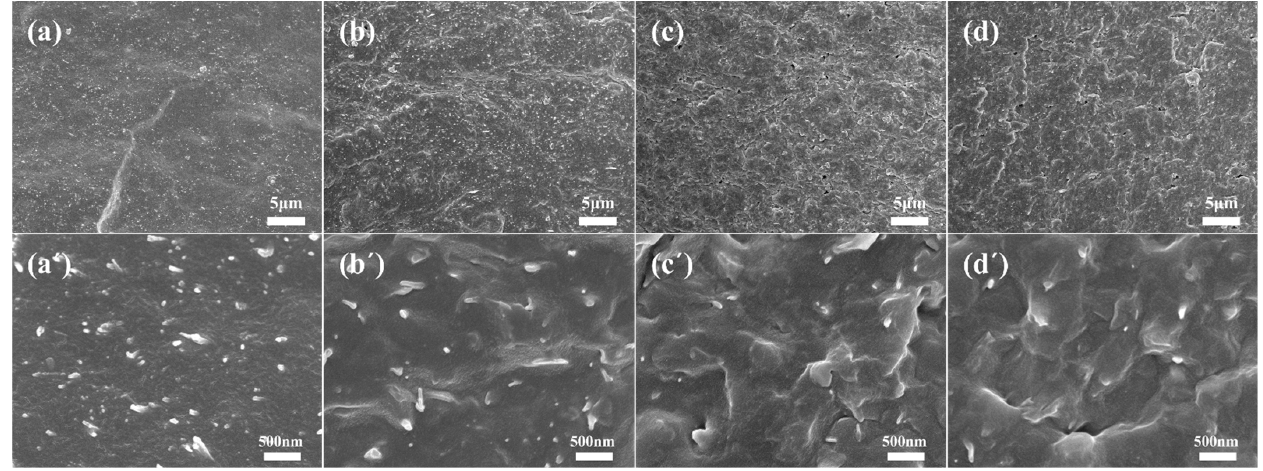
Figure 4. SEM micrographs of tensile fractured surfaces of ( a , a’ ) Sep/NR composite, ( b , b’ ) VSep/NR composite, ( c , c’ ) MSep/NR composite, and ( d , d’ ) TSep/NR composite.